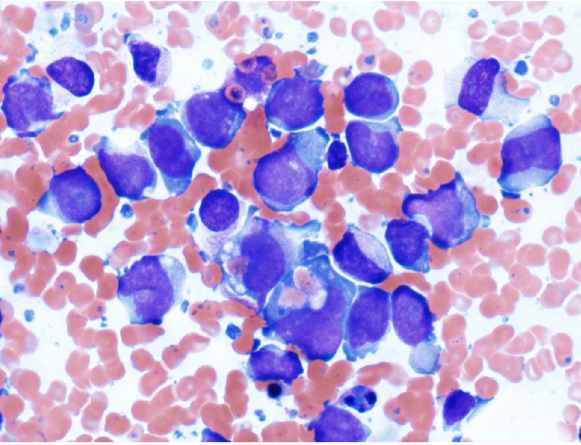
Figure 1. Bone marrow smear showing intermediate to large blasts with finely dispersed chromatin with variably abundant cytoplasm, vacuolization and phagocytosis of red blood cells (Wright-Giemsa 400 x).